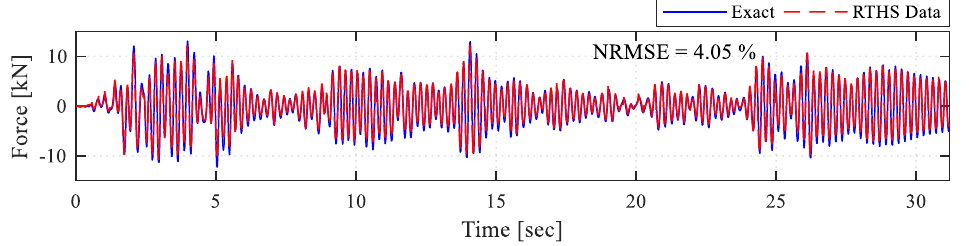
Figure 14. Brace obtained force feedback from Model 1b RTHS test without specimen as compared to the exact analytical solution.